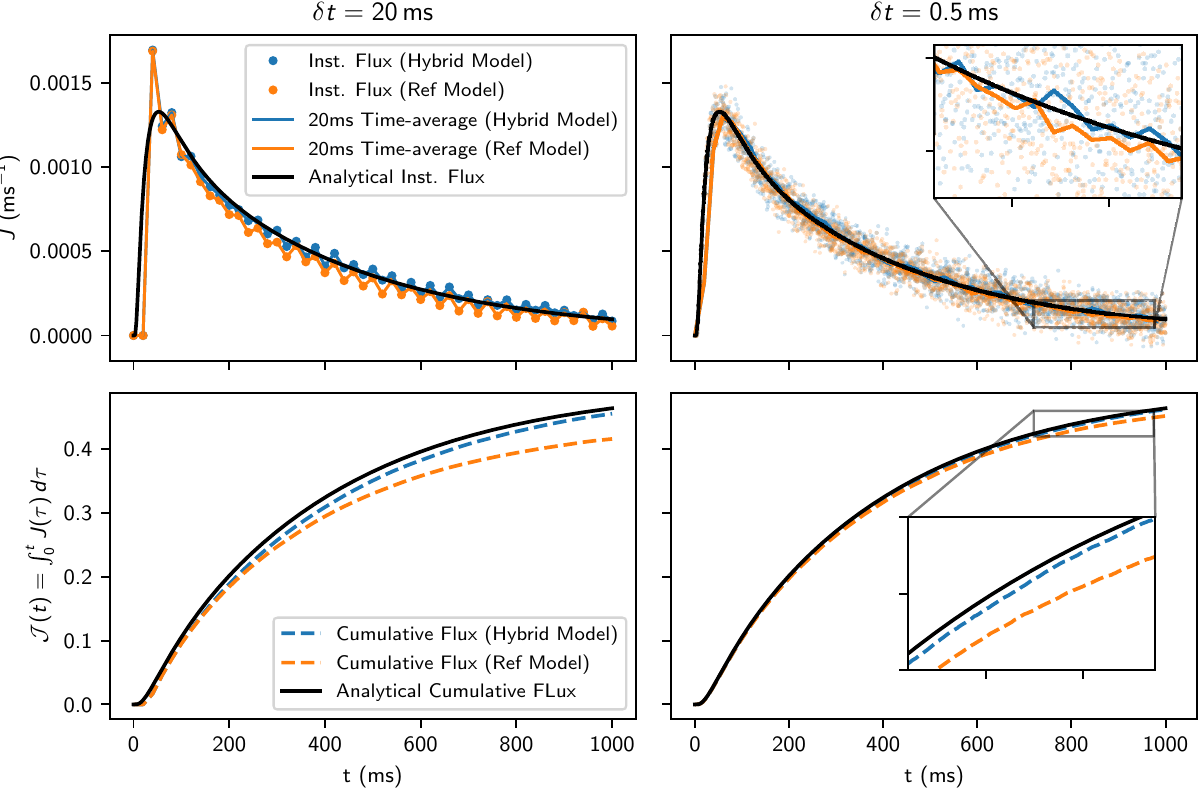
Figure 4. Top figures: instantaneous (numerical/analytical) and time-averaged (plotted as the average over 20ms ) fluxes J ( t ) through the membrane as a function of simulation time. Bottom figure: intervals of (cid:31) t = Analytical and numerical net cumulative flux. We show results for two different step sizes δ t : 20 and 0.5 ms . Domain and simulation parameters are D L 10 6 N p =